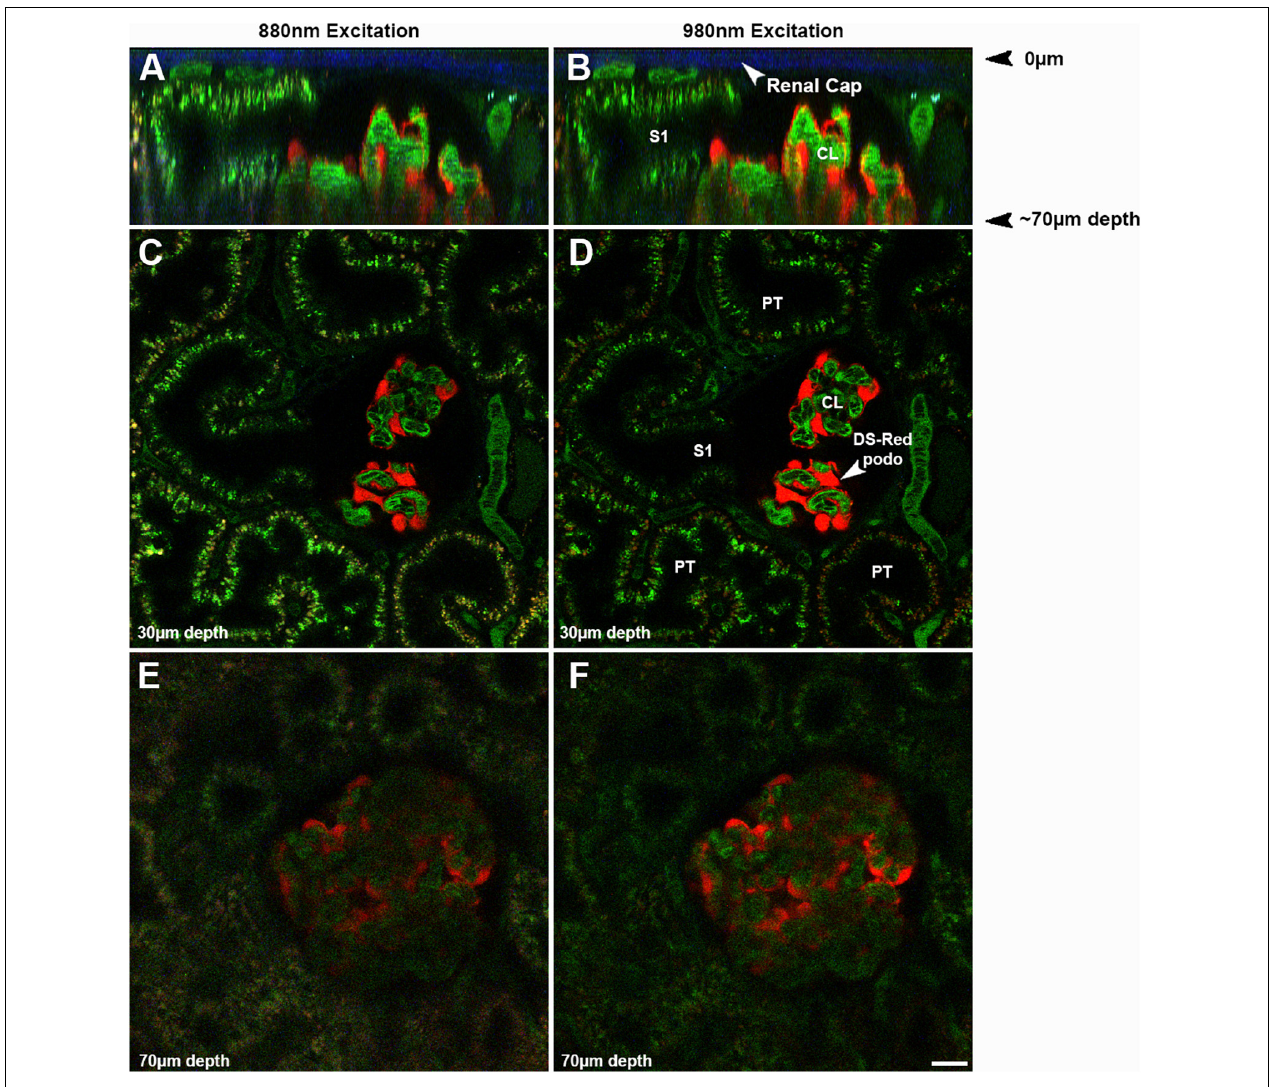
FIGURE 2 | Effect of imaging depth on image intensity and resolution: The same glomerulus in a strain of Munich Wistar Frömter rats, expressing the fluorescent protein DS Red selectively in podocytes, was imaged from 20 to 70 microns from the surface using two different wavelengths, 880 (A,C,E) and 980 nm (B,D,F) . Oregon Green 488 labeled rat serum albumin (OG488-RSA) was injected I.V. and can be seen in the vasculature, proximal tubules, and glomerulus. To assure illumination remained relatively constant from the upper to the lower optical sections in the image volume, the Linear Z-Compensation feature on the Leica Dive Multi-Photon system was utilized. (A,B) Show orthogonal the Linear Z-Compensation feature on the Leica Dive Multi-Photon system X-Z projections of a 73 µ m micron volume, with the glomerular surface at the top of the image; note the 2nd harmonic excitation of collagen in the renal capsule (arrows, blue).